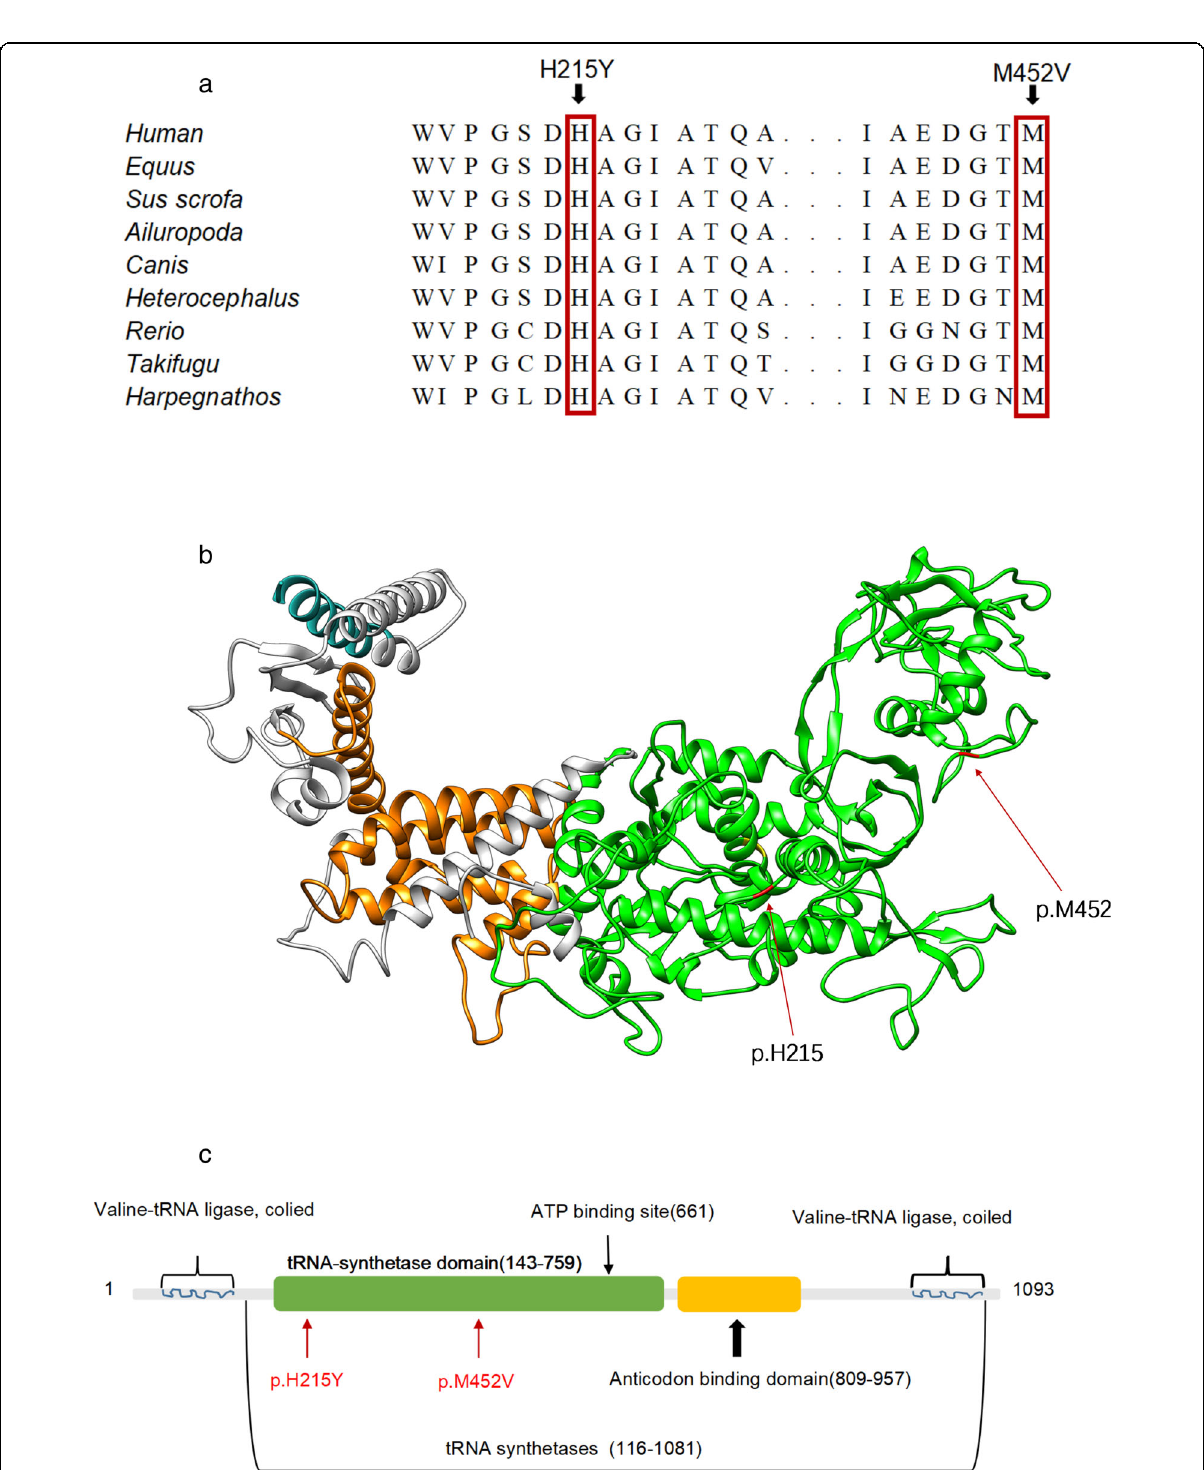
Fig. 3 Schematic diagram and molecular model of the VARS2 gene. a VARS2 sequence alignment among representative species around the sites of the missense mutations (p.H215Y and p.M452 V). b Homology model of VARS2 (partial amino acids from positions 129 to 1079). Different colors represent different functional regions: the compound heterozygous mutation (p.His215 and p.Met452) is shown in red, the valine-tRNA ligase region in blue, the ATP biding site in yellow, the tRNA-synthetase domain in green and the anticodon binding domain in orange. c Schematic representation of the VARS2 protein. The novel compound heterozygous mutation reported here coincides with the tRNA-synthetase